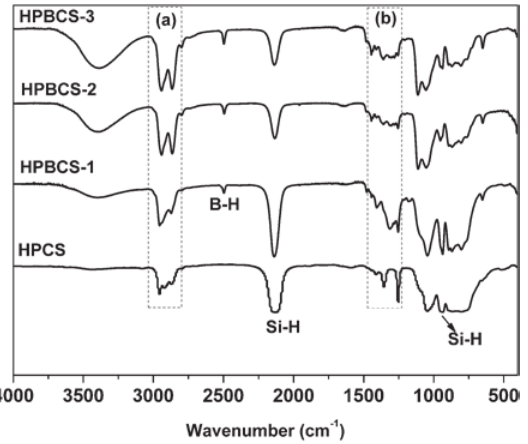
Fig. 2: FT-IR spectra of HPCS and HPBCS with different boron content in